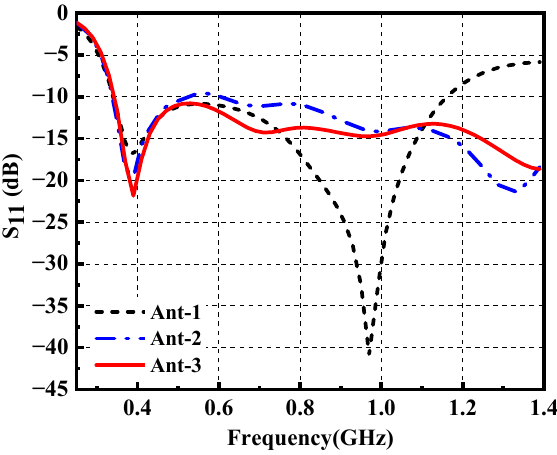
Figure 3. The reflection coefficient of the proposed antenna.